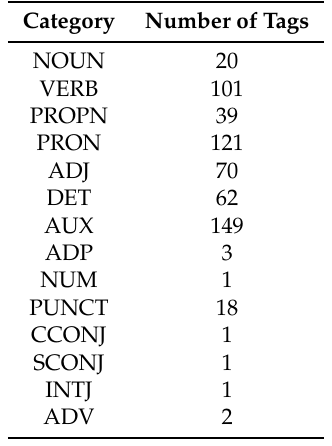
Table 3. Training and development: Tag set